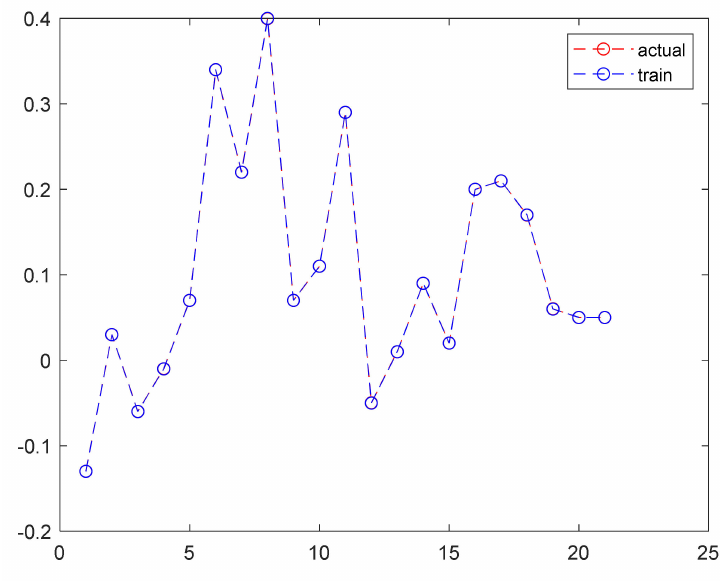
Figure 5. The training values and actual values of the N15 indicator.